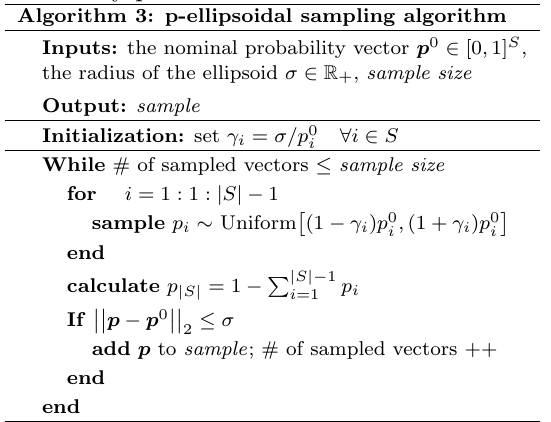
Algorithm 3: p-ellipsoidal sampling algorithm